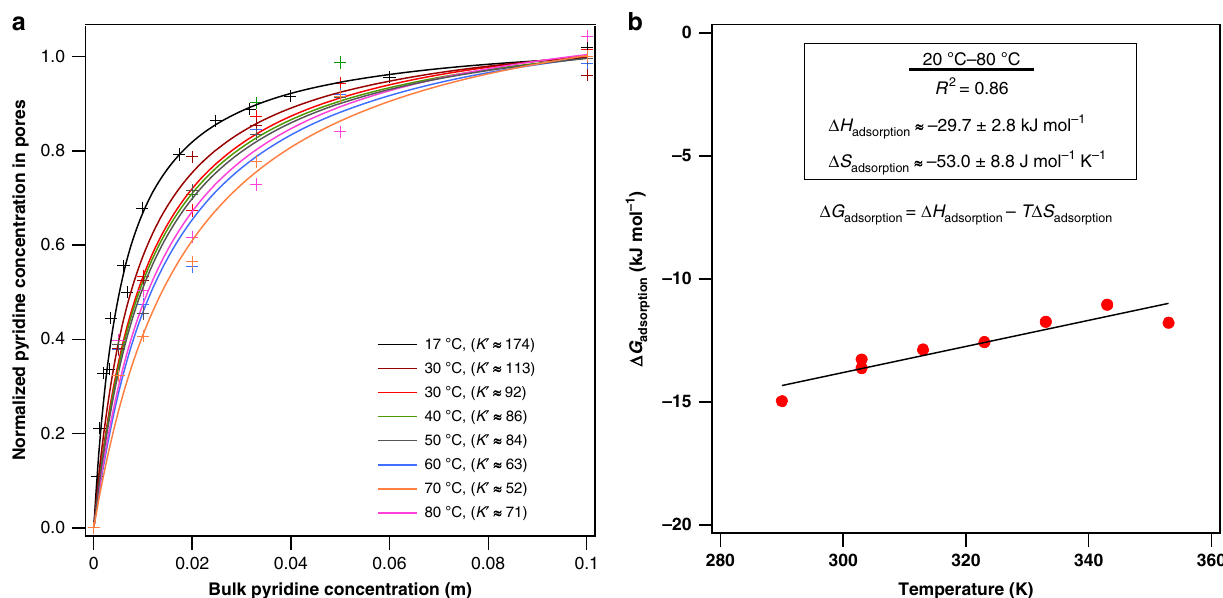
Fig. 7 Pyridine adsorption isotherms on Si/ZSM-5 at different temperatures. a Pyridine adsorption isotherms onto Si/ZSM-5 in water at various temperatures. Langmuir parameters ( K ′ ) in legend. b In fi nite dilution Δ H ads and Δ S ads from 20 to 80 °C in water on Si/ZSM-5. Error bars in B) are standard